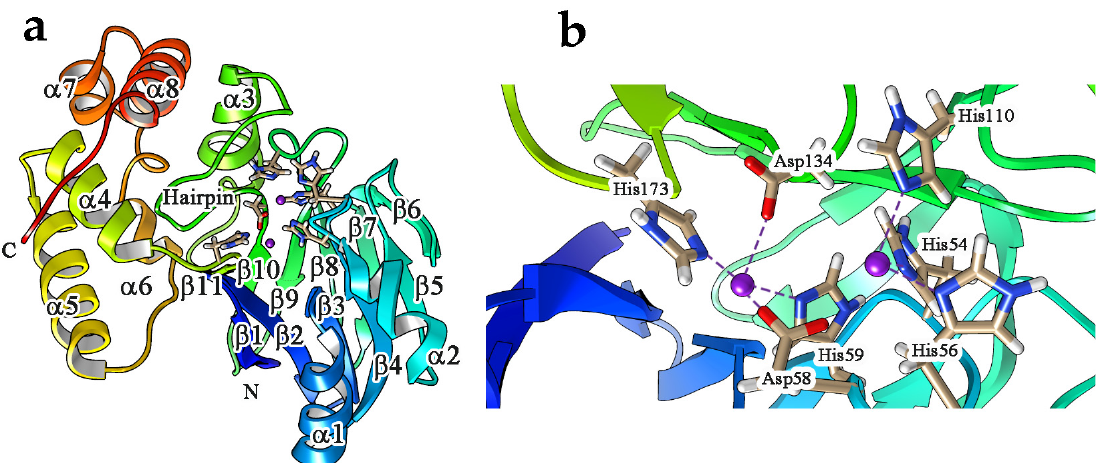
Figure 3. ( a ) Solid ribbon representation of human Glo2. The molecule has been color ramped according to residue number starting with red at the N terminus and finishing with blue at the C terminus. The metal ions and the coordinating residues are shown with balls and sticks. ( b ) Detail of zinc ion coordination by His and Asp residues at human Glo2 active site. The two images have been obtained from 1QH5